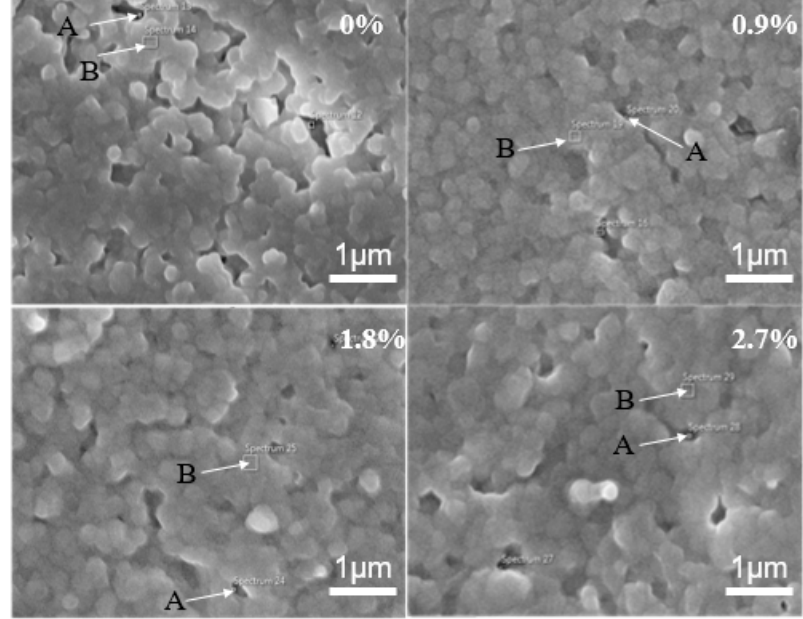
Figure 3. SEM pictures of the microwave-sintered 3Y-TZP ceramics as function of nano TiO 2 powders, sintered at 1250 °C (A is directed to grain and B is directed to grain boundary).